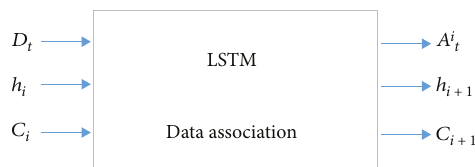
Figure 6: LSTM-based architecture for data association.